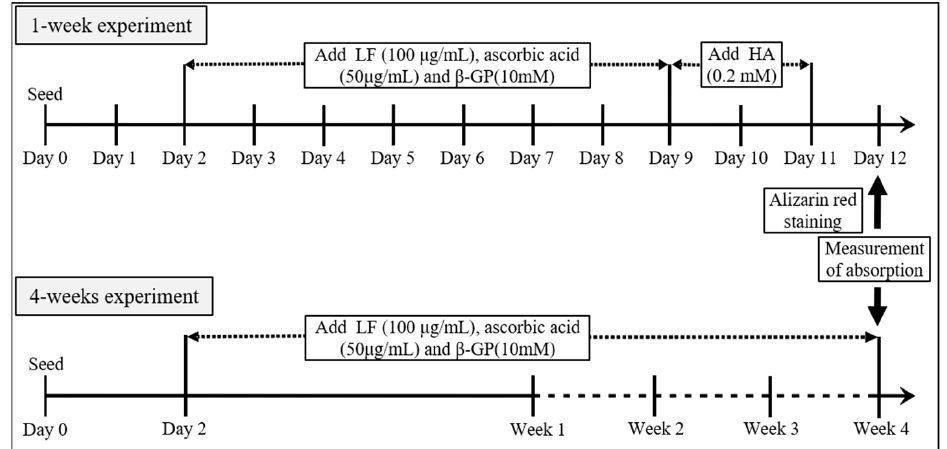
Figure 1. Schedule of alizarin red staining in the 1- and 4-week experimental designs. The MC3T3-E1 cells were seeded, and 100 μ g/mL IF-I and LF-II treatments were added along with ascorbic acid (50 μ g/mL) and β -GP (10 mM) after 2 d. Absorbance was measured at 1 week of incubation with HA (0.2 mM) treatment, and after 4 weeks of incubation without HA. LF, lactoferrin; HA, hydroxyapatite; β -GP, β -glycerophosphate.